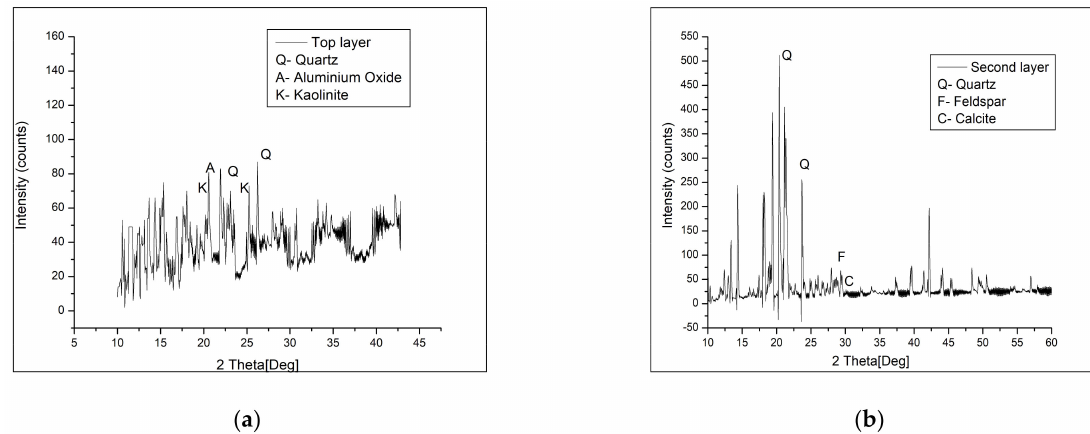
Figure 11. X-ray diffraction pattern for ( a ) the topsoil layer; ( b ) the bottom soil